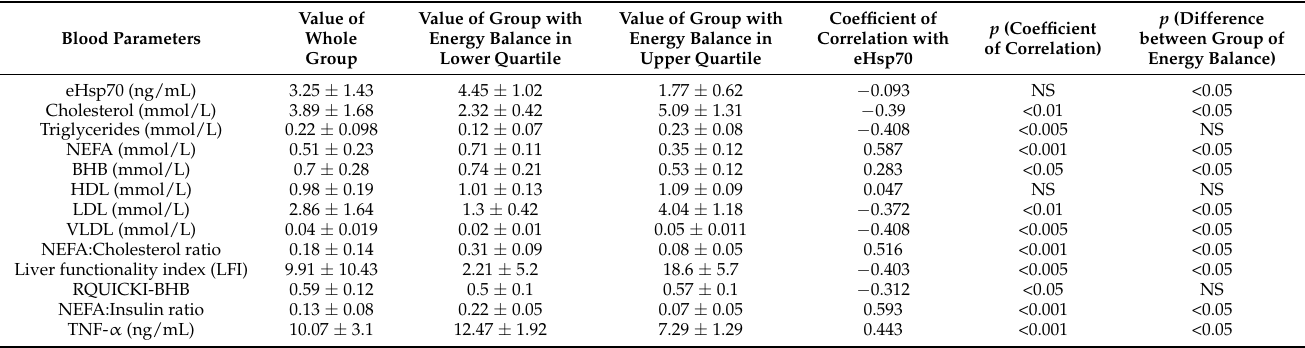
Blood Parameters